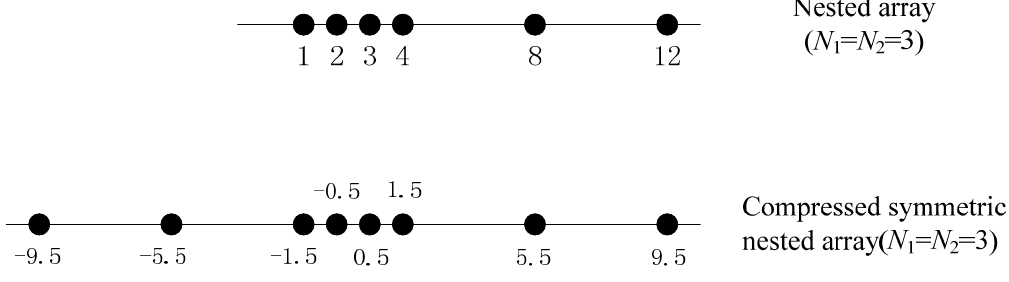
3, 3 N N   ) and compressed symmetric nested array ( Figure 2. Nested array ( N 1 = 3, N 2 = 3) and compressed symmetric nested array ( N 1 = 3, N 2 = 3). Figure 2. Nested array ( 1 2 The difference co-array of the two arrays contains the same Table 1. The relationship between the number of sensors and DOF of CSNA. The Number of Sensors